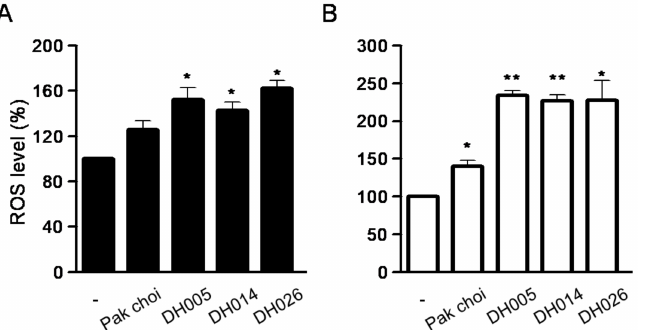
Figure 5. Effects of high glucosinolate (GSL) (HGSL) doubled haploid (DH) lines (DHLs) (DH005, DH014, and DH026) on intracellular reactive oxygen species (ROS) production in human colorectal cancer (CRC) cells. HCT116 ( A ) and SW480 ( B ) cells were treated with 2.5 mg/mL of each HGSL DH or pak choi extract for 24 h. ROS generation was measured by 2,7-dichlorofluorescein diacetate (DCF-DA) staining with flow cytometry analysis. Every staining and analysis was performed at least three times in duplicate. Data represent the mean ± SEM. (*, p < 0.05 and **, p < 0.01 versus